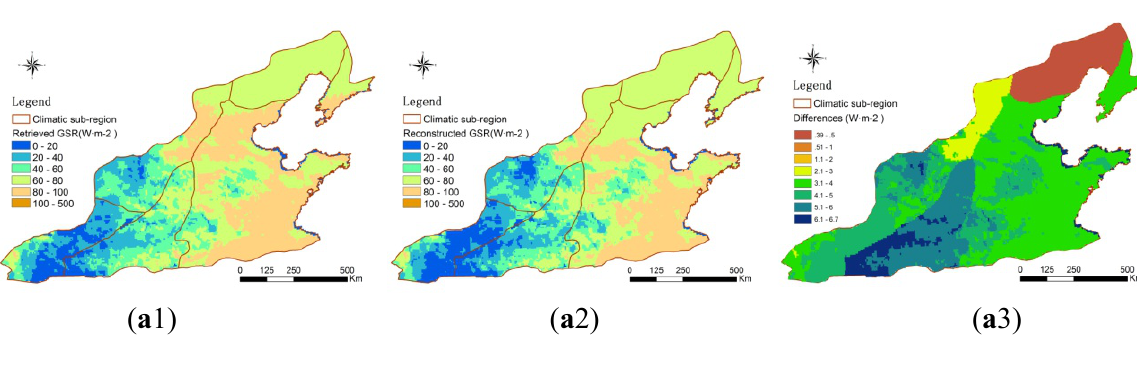
Figure 4. The distribution of global solar radiation on ( a ) 15 February; ( b ) 15 May; ( c ) 15 August; and ( d ) 15 November,